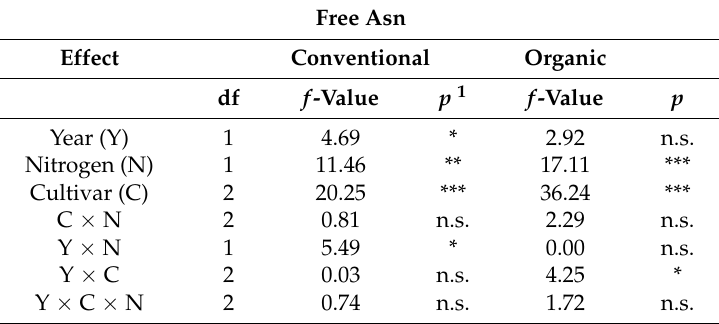
Table 5. F-values and p -values of -free Asn separated by cropping system for the main effects year, nitrogen, and winter wheat cultivar as well as forinteractions between main effects, df = degree of